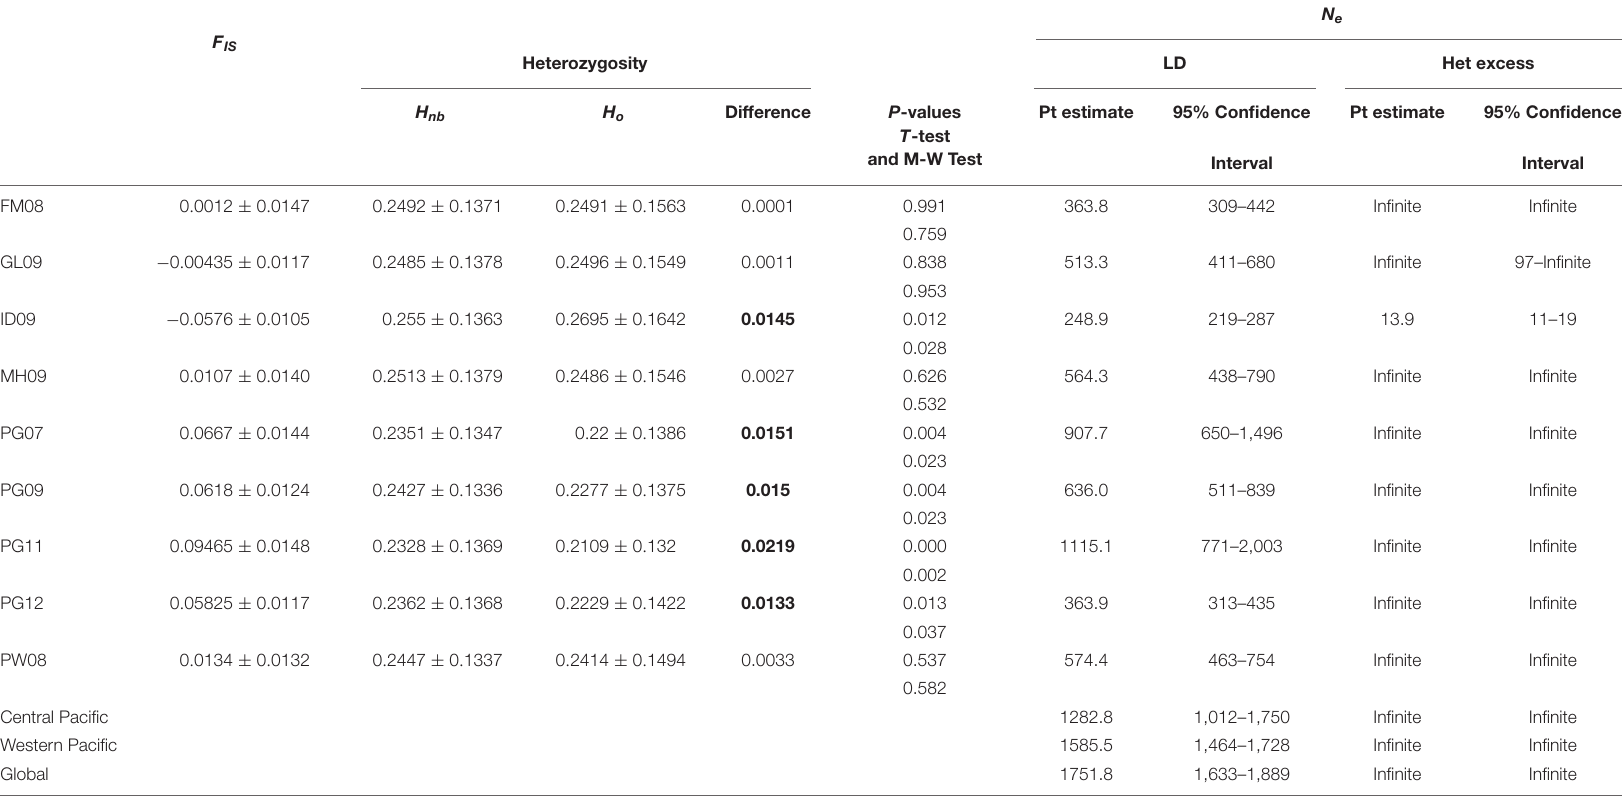
TABLE 4 | Inbreeding coefficient ( F IS ), expected and observed heterozygosity ( H nb and H o , respectively), p -values for significant differences between H nb and H o , p values for difference measured by T -test and Mann-Whitney Test (significant p -values in bold), and effective population size ( N e ) calculated using the primary dataset.